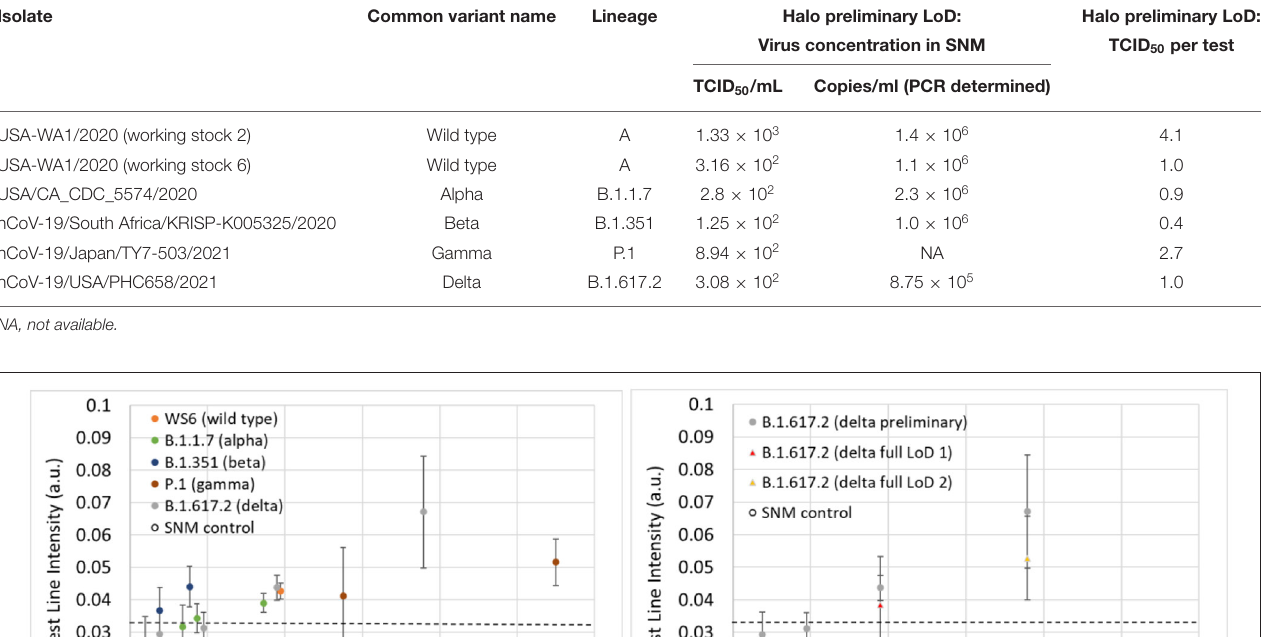
TABLE 1 | Preliminary LoD in SNM—Halo Reader Live Virus in SNM. Isolate